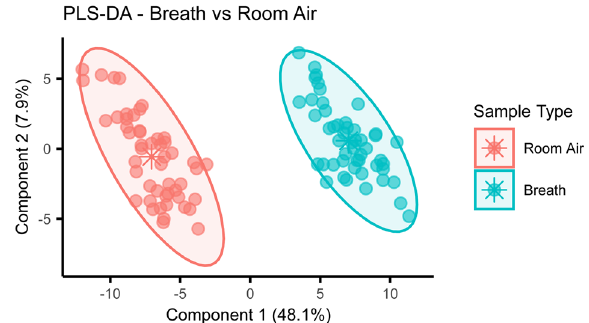
Figure 1. Breath and room air present distinct VOCs profiles. Supervised analysis with PLS-DA showed a clear separation between breath and room air VOCs profiles collected during the morning (R 2 Y = 0.97, Q 2 Y = 0.96, p < 0.001). Repeated measures were collapsed to the mean before model construction. Ellipses show 95% confidence intervals and asterisks group